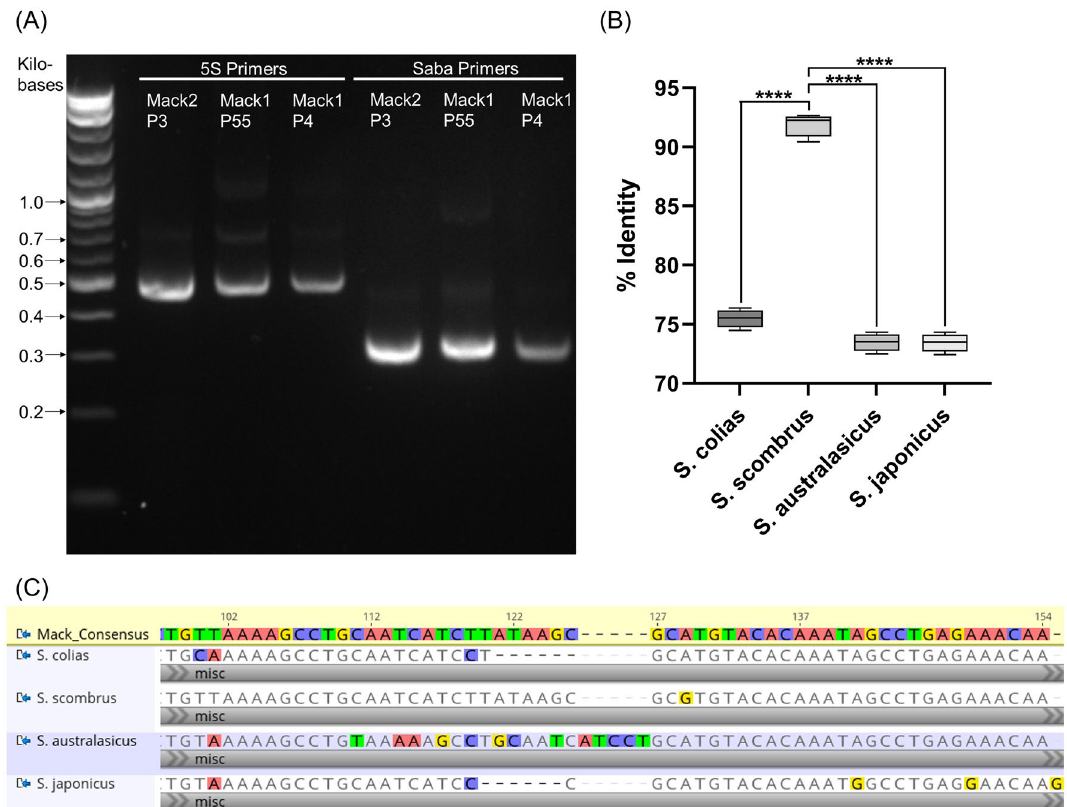
Figure 1. PCR confirmation of S. scombrus identity. ( A ) PCR amplification of Mack cell genomic DNA (Mack2 P3, Mack1 P55, Mack1 P4) with fish universal 5S primers and Scomber -specific Saba primers, with apparent band size matching expected size of 486 bp and 311 bp, respectively. The original gel is presented in Supplementary Fig. S1. ( B ) Comparison between Scomber species of Geneious Prime nucleotide alignment identity percentages of Sanger sequencing from Saba PCR reaction. Whiskers indicate min to max, n = 4; statistical significance calculated by one-way ANOVA with multiple comparisons between the control S. scombrus and the other species and indicated by asterisks, in which p < 0.0001 (****). ( C ) Section of Geneious Prime alignment of the consensus mackerel nucleotide sequence (n = 4) and the four Scomber (Supplementary Fig. S3C). In fact, Mack2 cells demonstrated robust muscle fiber formation, as confirmed with M-F20 staining (Supplementary Fig. S4). Lipid accumulation towards adipogenic‑like phenotype. While muscle is the predominant com- ponent of fish fillets, fat plays an important role in flavor and texture. Fat is especially pronounced in mackerel, as it is often described as an oily fish 22,23 . Thus, to investigate the potential for mackerel muscle cells to accu- mulate lipids, induction towards an adipogenic-like phenotype was explored through media supplementation. Specifically, medium was supplemented with a lipid mixture and PPARG agonists (dexamethasone, 3-isobutyl- 1-methylxanthine (IBMX), and insulin), as PPARG is the master regulator of adipogenic differentiation 20 . Inclu- sion of the lipid mixture with the agonists promoted lipid accumulation, confirmed through ORO staining and quantification of extracted ORO (Fig. 4A,B). Lipidomics was used to characterize the fatty acid profiles of adipogenic-like cells and compared against published data for native Atlantic mackerel and cod liver oil, which is in the lipid mixture of the adipogenic medium. Fatty acid composition was binned into saturated fatty acids (SFAs), monounsaturated fatty acids (MUFAs), and polyunsaturated fatty acids (PUFAs) to compare lipid composition (Fig. 4C). In comparison to native mackerel, cultured cells contained relatively higher MUFA levels and lower SFA levels. In comparison to cod liver oil, the cultured cells contained lower levels of MUFAs. Specific fatty acid composition from the top 13 most prevalent fatty acids in the in vitro mackerel are exhibited in Fig. 4D. Of note, oleic (18:1) and linoleic (18:2) acids appear enriched in the in vitro samples, while docosahexaenoic acid (22:6) was lower (Fig. 4D). More specific investigation into the composition of the phospholipids, which constitute the cell membrane and are associated with t aste, and triacylglycerides, which are the storage form of fat and constitute most of the lipids present, are presented in Supplementary Fig. S5.